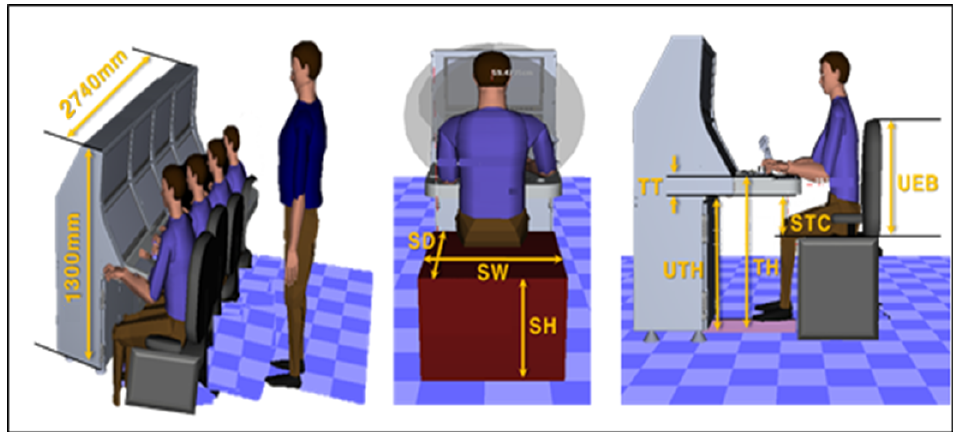
Figure 2. Submarine naval multi-function console design dimensions. Seat height (SH), vertical distance from the floor to the highest area of the seat pan; seat width (SW), horizontal distance from the left to the right side of the widest part of the seat pan; seat depth (SD), horizontal distance from the front to the rear of the longest part of the seat pan; upper edge height of backrest (UEB), vertical distance from the seat pan surface to the upper edge of the backrest (UEB); worktable height (TH), vertical distance from the floor to the worktable surface; underneath worktable height (UTH), vertical distance from the floor to the lowest point below the worktable; worktable thickness (TT), thickness of the worktable hardboard; and seat to table clearance (STC), vertical distance from the seat pan surface to underneath the